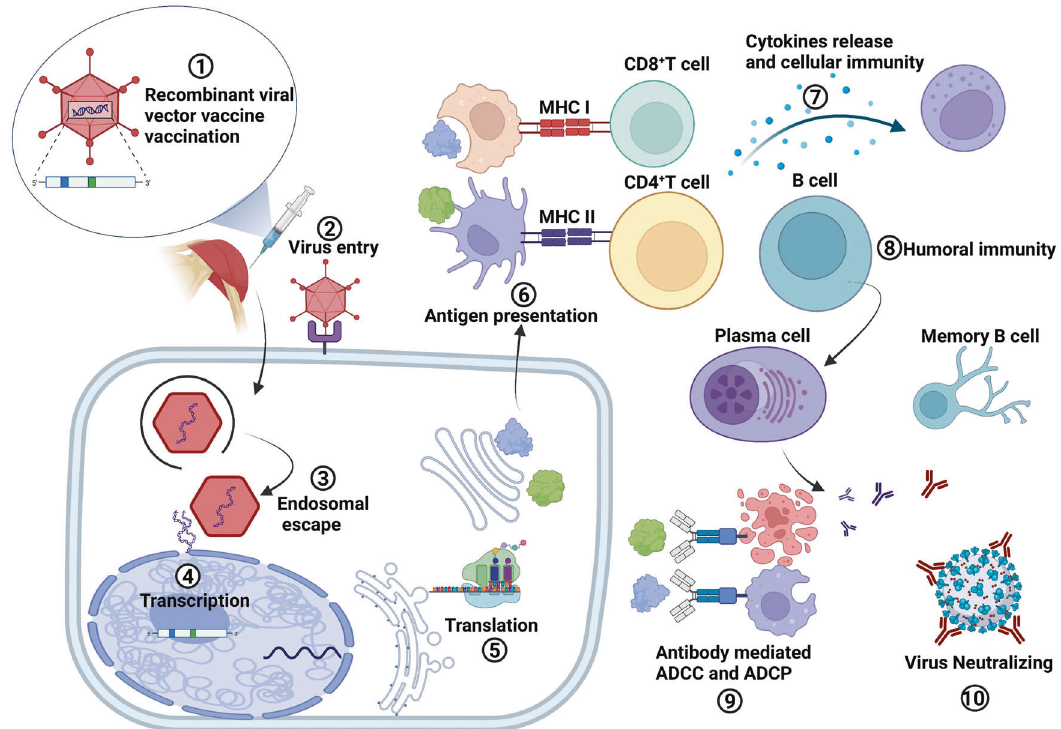
Fig. 3 Antigen presentation mechanisms of intramuscular-delivered viral vector vaccine. (1) Construction and vaccination of a recombinant viral vector vaccine. (2) Viral vector vaccine is taken up by muscle cells through endocytosis. (3) Endosome escape from viral vector vaccine. (4) Partially disassembled virus capsid traf fi c to the nucleus, initiating the transcription process. (5) Protein translation and post-translational modi fi cation in endoplasmic reticulum and golgi apparatus. (6) Antigen proteins are presented to antigen presenting cells. The antigen can be loaded onto MHC class I for direct presentation to CD8 + T cells, and loaded onto MHC class II for direct presentation to CD4 + T cells. (7) T cells lyse infected cells under the mediation of cytokines. (8) Stimulated B cells differentiate into memory B cells and antibody-releasing plasma cells. (9) Antigen proteins are recognized by antibodies, including those capable of Fc-mediated effector function, including antibody- mediated cellular cytotoxicity and antibody-dependent cell-mediated phagocytosis. (10) Neutralizing antibodies neutralize pathogens and block their entry. (Created in